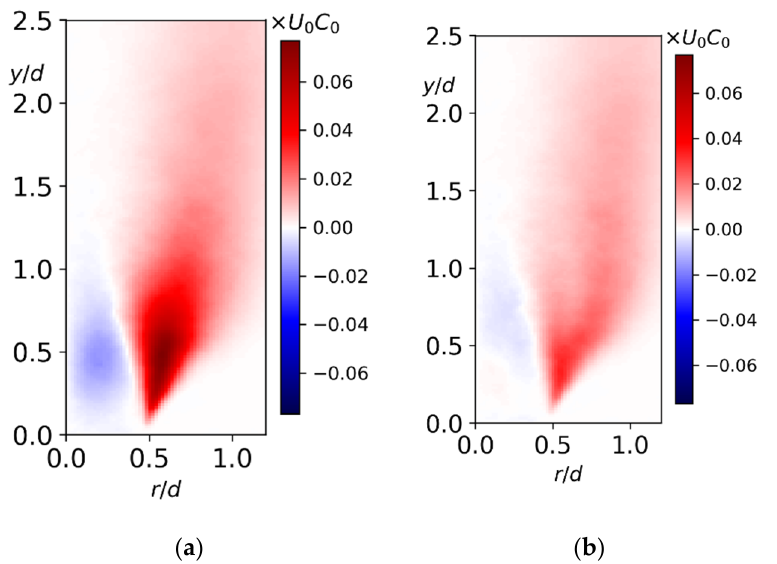
(cid:68) (cid:68) (cid:69) (cid:69) ′ ′ (cid:10) (cid:11) ′ ′ , and the uu u u ′ ′ , ( b ) u u , ( c ) u (cid:48) r u (cid:48) y u (cid:48) r u (cid:48) u (cid:48) y u (cid:48) , ( b ) , ( c ) , and the θ θ r r y y θ θ (cid:10) (cid:11) (cid:10) (cid:11) (cid:10) (cid:11) ′′ ′′ u (cid:48)(cid:48) r u (cid:48)(cid:48) y u (cid:48)(cid:48) r u (cid:48)(cid:48) u (cid:48)(cid:48) y u (cid:48)(cid:48) , ( e ) , and ( f ) for high-swirl jet. ′′ ′′ for high-swirl jet. uu u u ′′ ′′ , ( e ) u u , and ( f ) θ θ θ θ r r y y